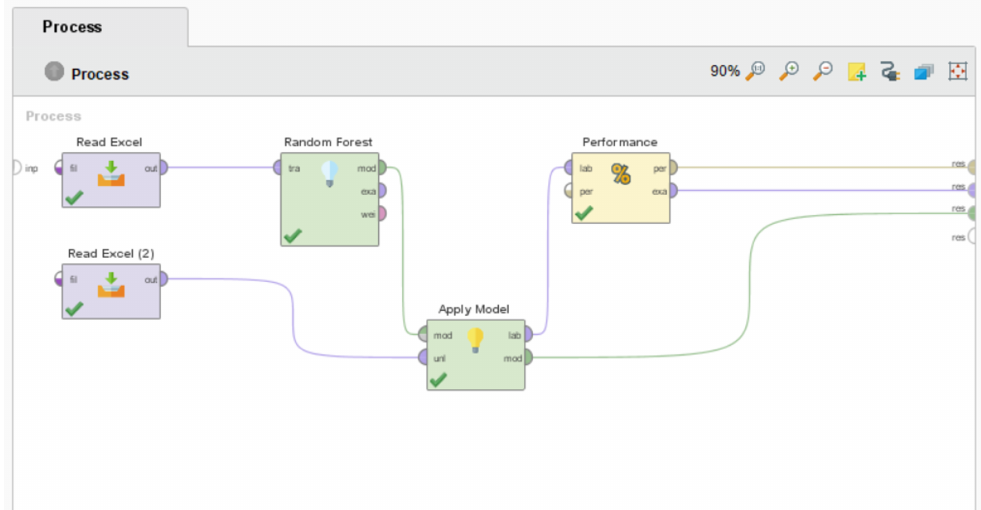
Figure 2. Design view of the construction of a working process for a standard computational model in RapidMiner, according to